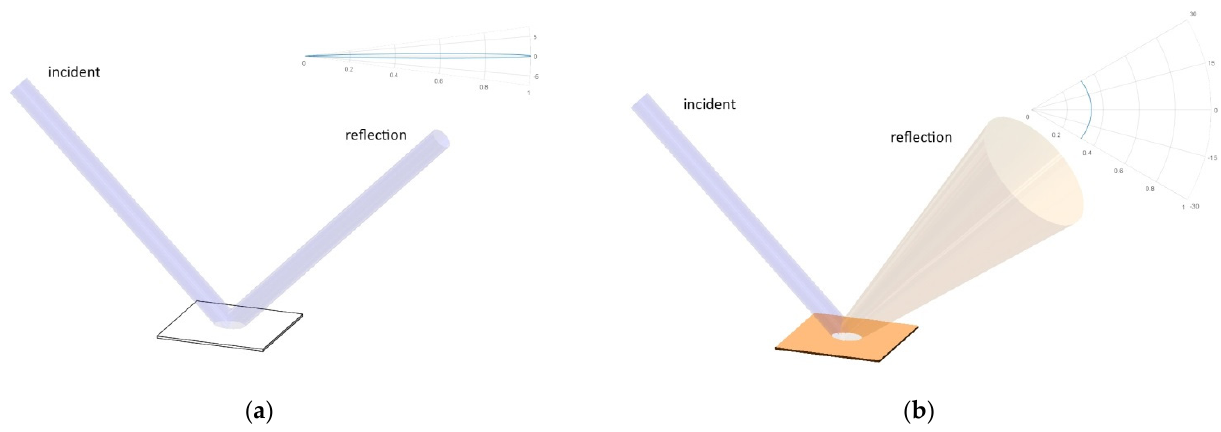
Figure 1. The reflection of terahertz beam on surfaces of different BRDF-characteristics, ( a ) the specular reflection and ( b ) the diffuse reflection.